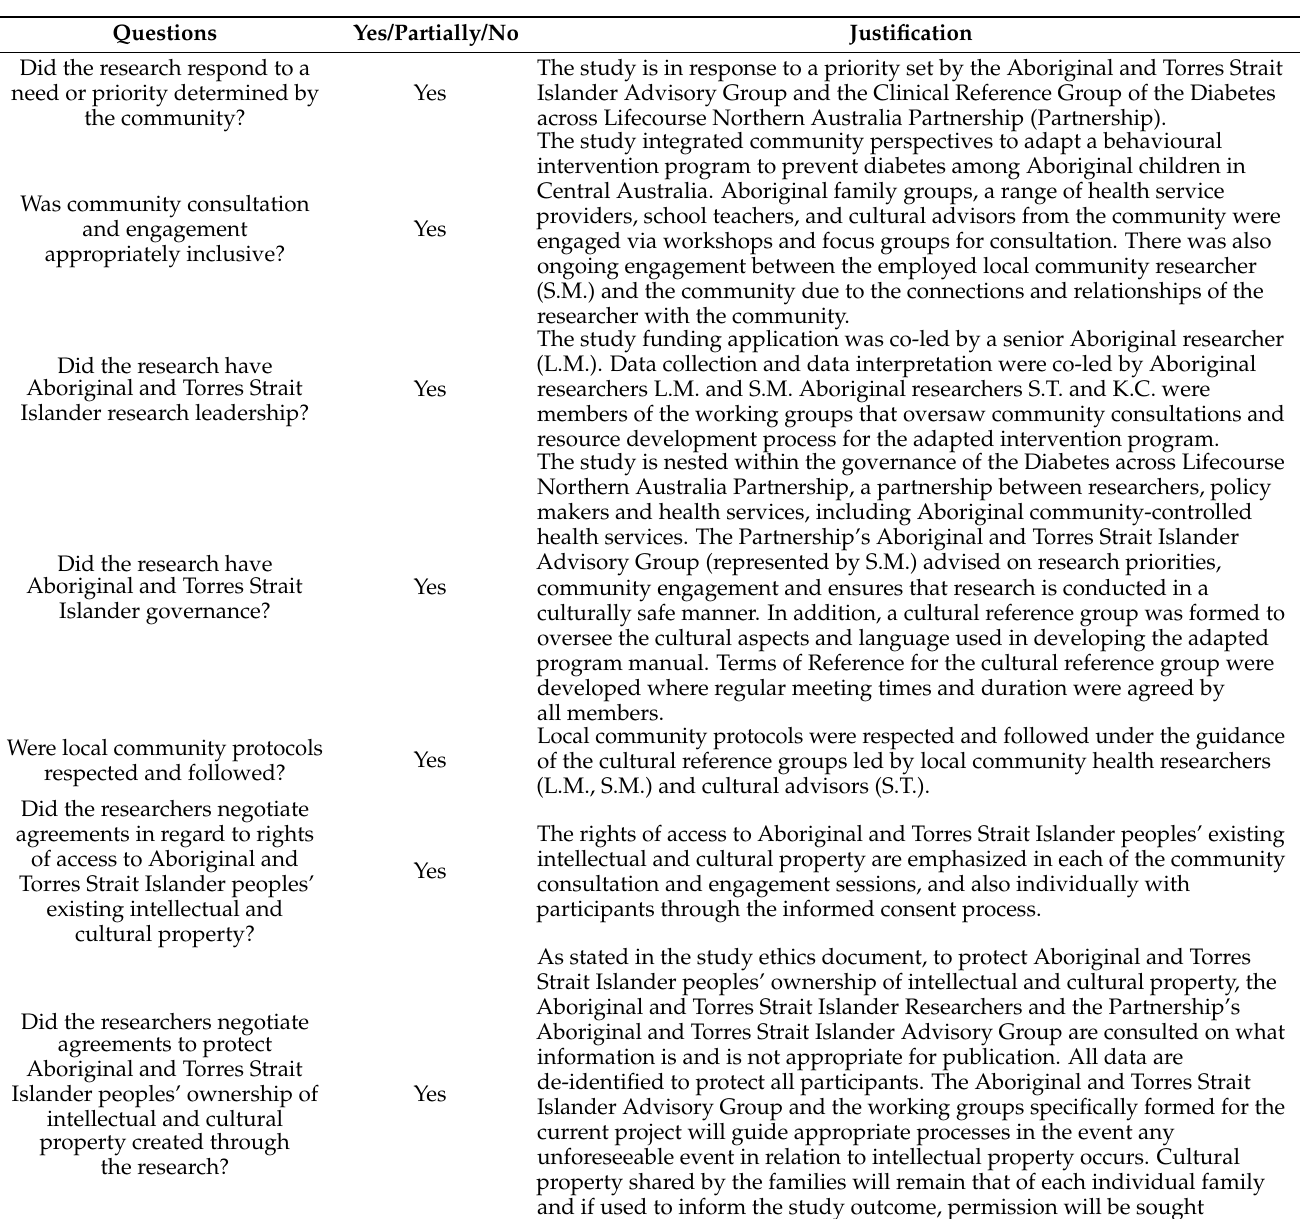
Table 2. Aboriginal and Torres Strait Islander quality appraisal tool